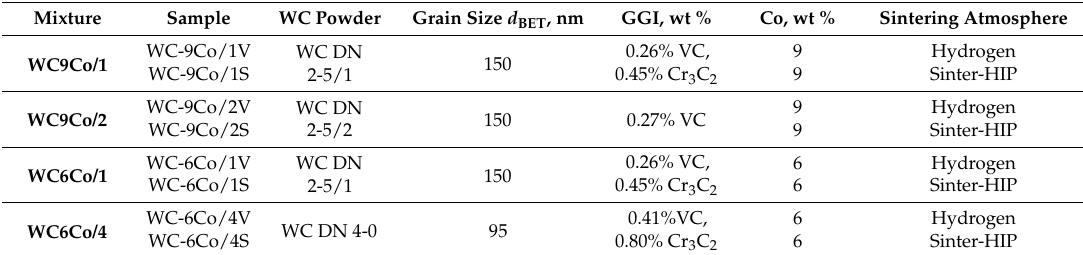
Table 1. Characteristics of mixtures and